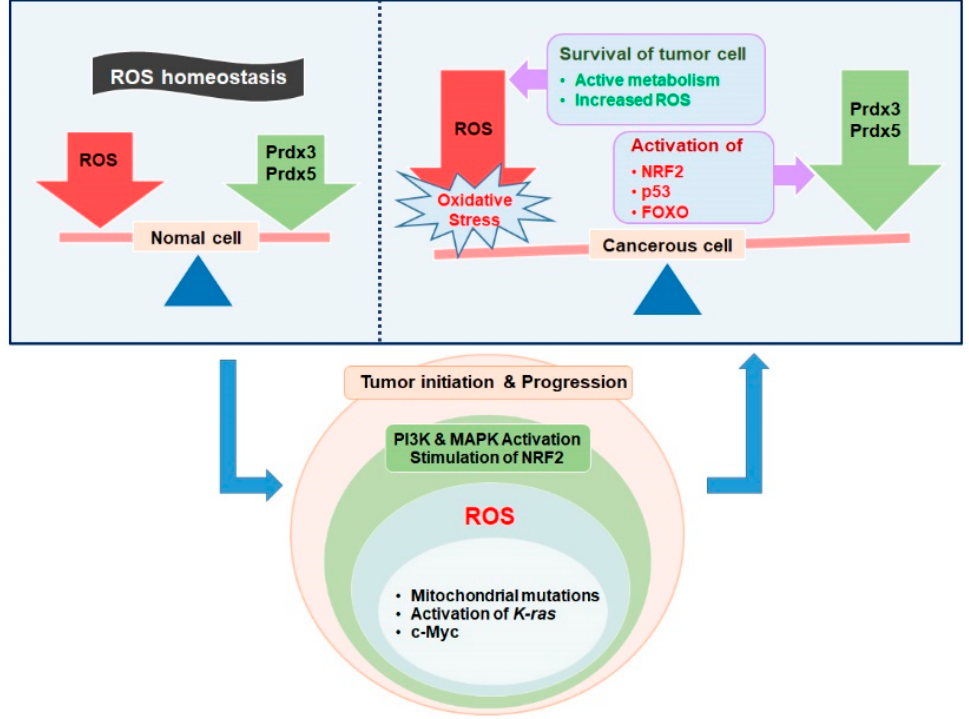
Figure 3. Role of antioxidants in cancerous cells. Mutations in mitochondria and mitochondrial dysfunctions lead to the production of increased amount of ROS by the activation of c-Myc and K-ras factors. The increased production of ROS leads to an imbalance between ROS and its scavengers. This imbalance activates a number of signaling pathways such as PI3K and mitogen-activated protein kinase (MAPK), resulting in tumor initiation and progression. The increased amount of ROS in cancerous cells requires an upregulated expression of antioxidants to prevent cell death. Thus, the activation of certain transcription factors (NRF2 and FOXO) and tumor suppressors (p53) induces the upregulation of mitochondrial Prdxs to compensate the increased production of ROS. Thus, mitochondrial Prdxs along with other scavengers act to protect the cancerous cells from ROS- mediated cell death.